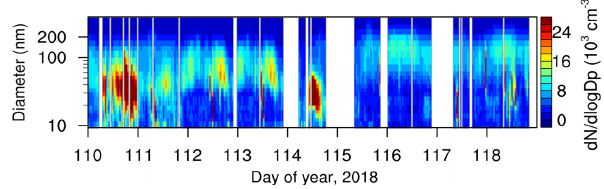
Figure 4. Contour plot of particle number size distribution on DOYs 110–118 with ship self-emission signals